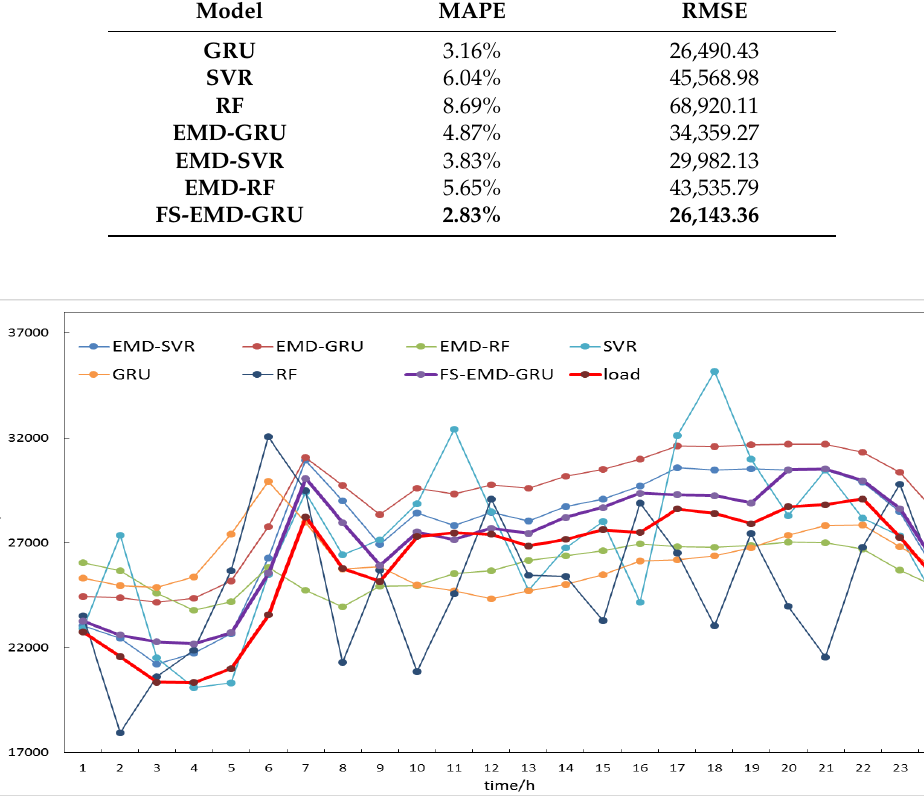
Figure 9. Comparisons of load forecasting results for a certain day in April 2006 of M_1